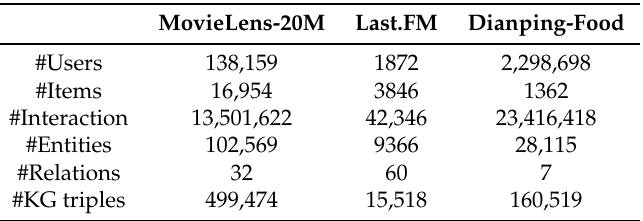
Table 2. Statistics of the datasets.